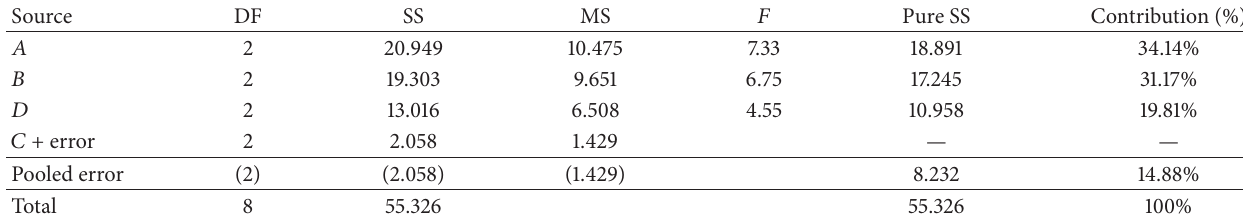
Table 4: Results of the analysis of variance for S/N ratios.